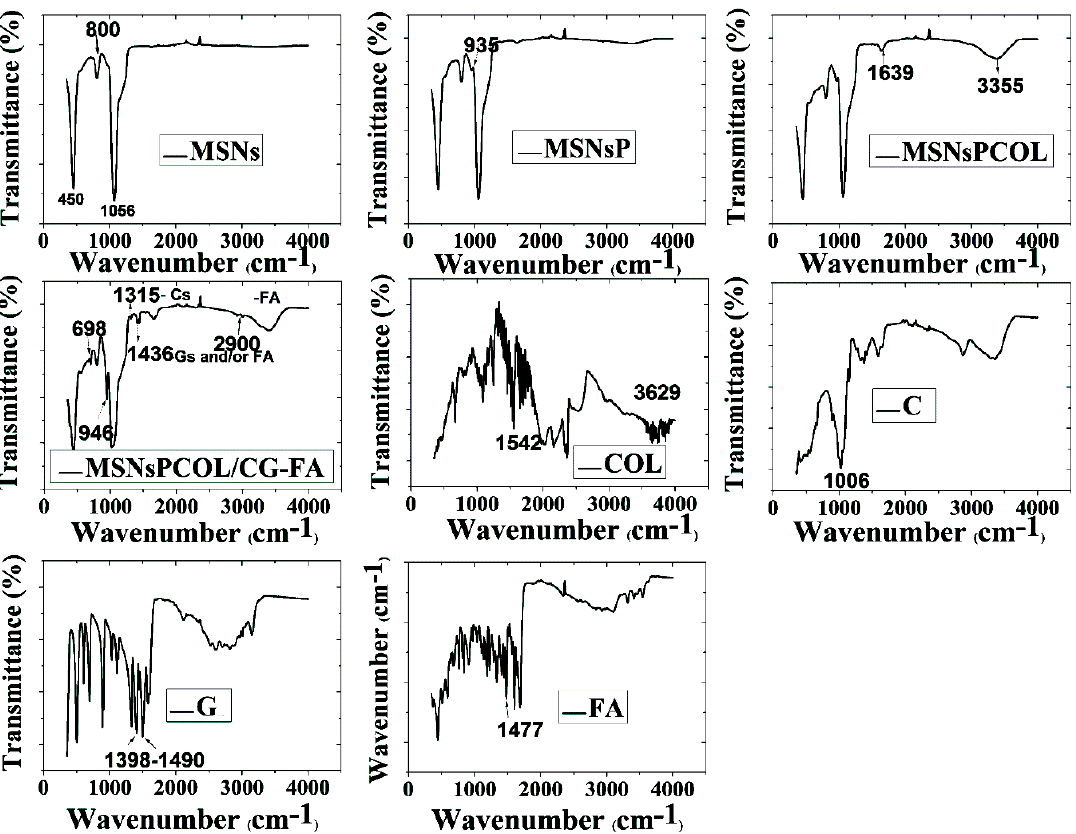
Figure 3. Fourier transform infrared spectroscopy (FTIR) spectra of MSNs before and after modification and COL loading, as well as chitosan (C), and glycine (G), folic acid (FA), and COL.